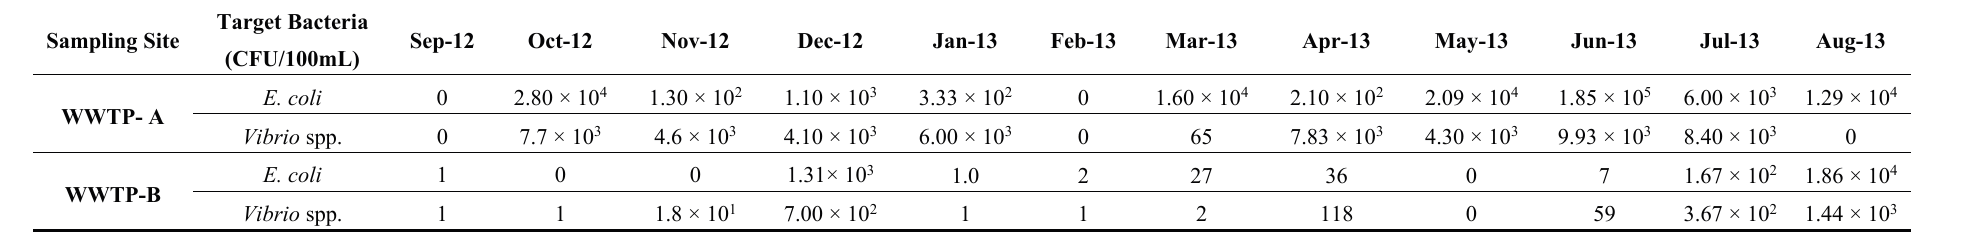
Table 4. Mean bacterial counts for the wastewater treatment